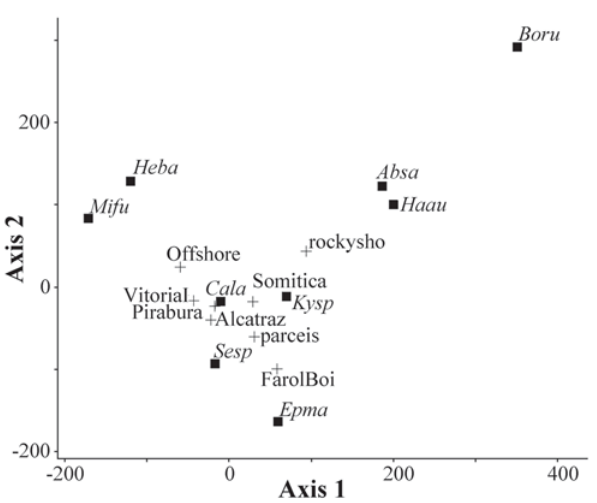
Fig. 6. Ordination plot of the correspondence analysis (first two axes) based on fishermen’s answers about migratory routes of the nine studied fish species in the southeastern Brazilian coast: Absa = Abudefduf saxatilis ; Boru = Bodianus rufus ; Cala = Caranx latus ; Epma = Epinephelus marginatus ; Haau = Haemulon aurolineatum ; Heba = Hemiramphus balao ; Kysp = Kyphosus spp.; Mifu = Micropogonias furnieri ; Sesp = Seriola